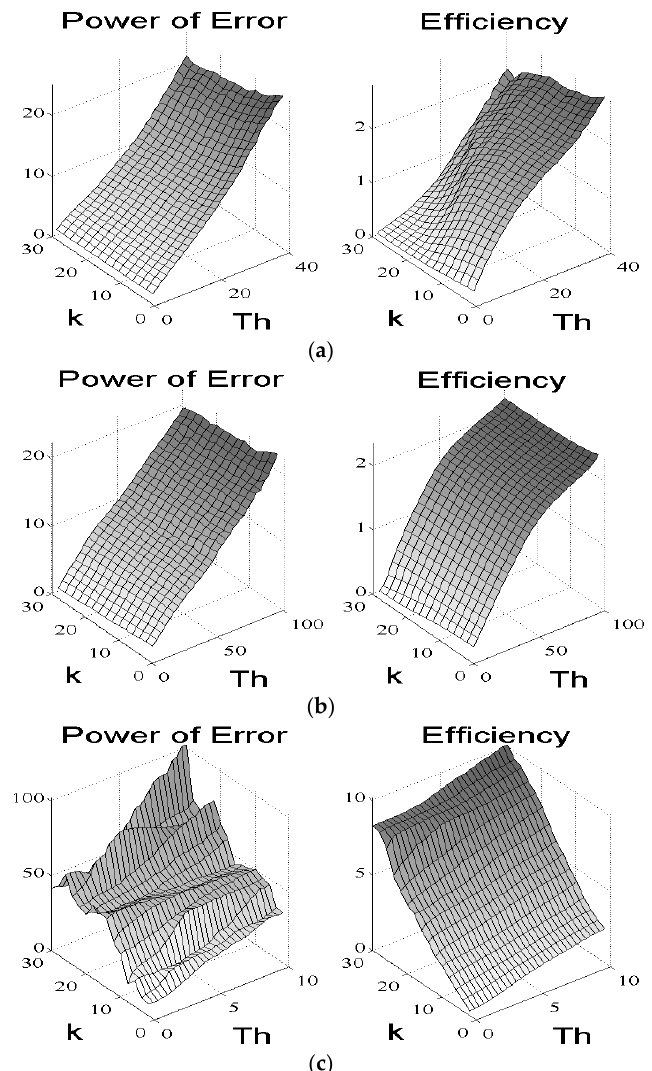
Figure 8. Effects of k, Th, ErrorFnc on approximation performances. ( a ) PLA using RMSE; ( b ) PLA using Euclidean Error; ( c ) PLA using Euclidean Distance.